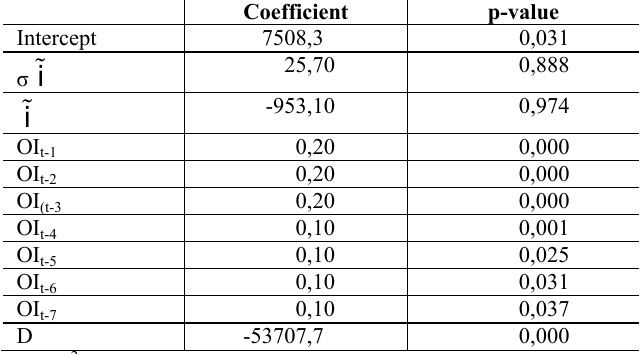
Table 8: Regression summary of volatility on